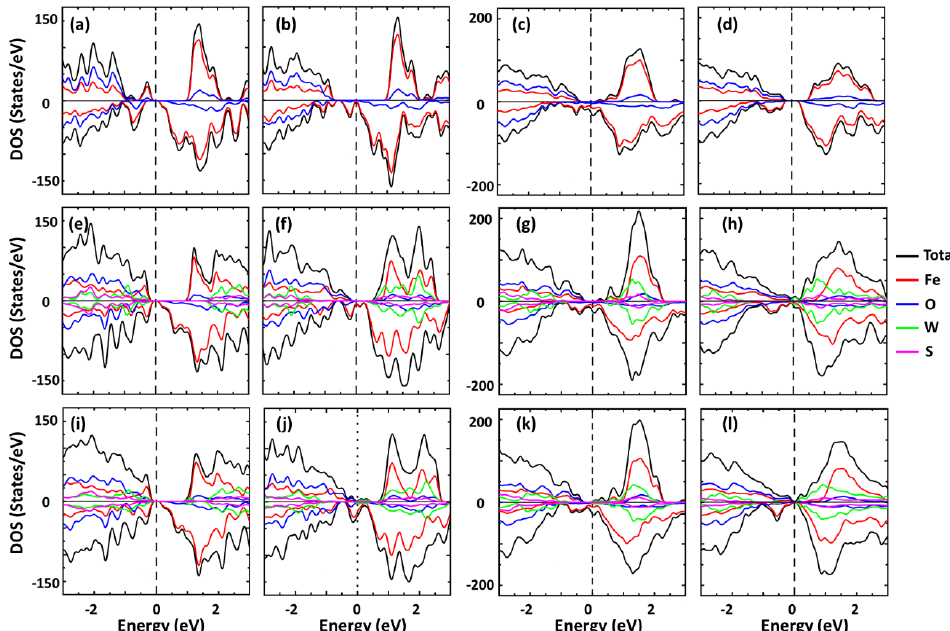
Figure 5. Total and atomically resolved density of states for a standalone Fe 3 O 4 layer: ( a ) cubic −